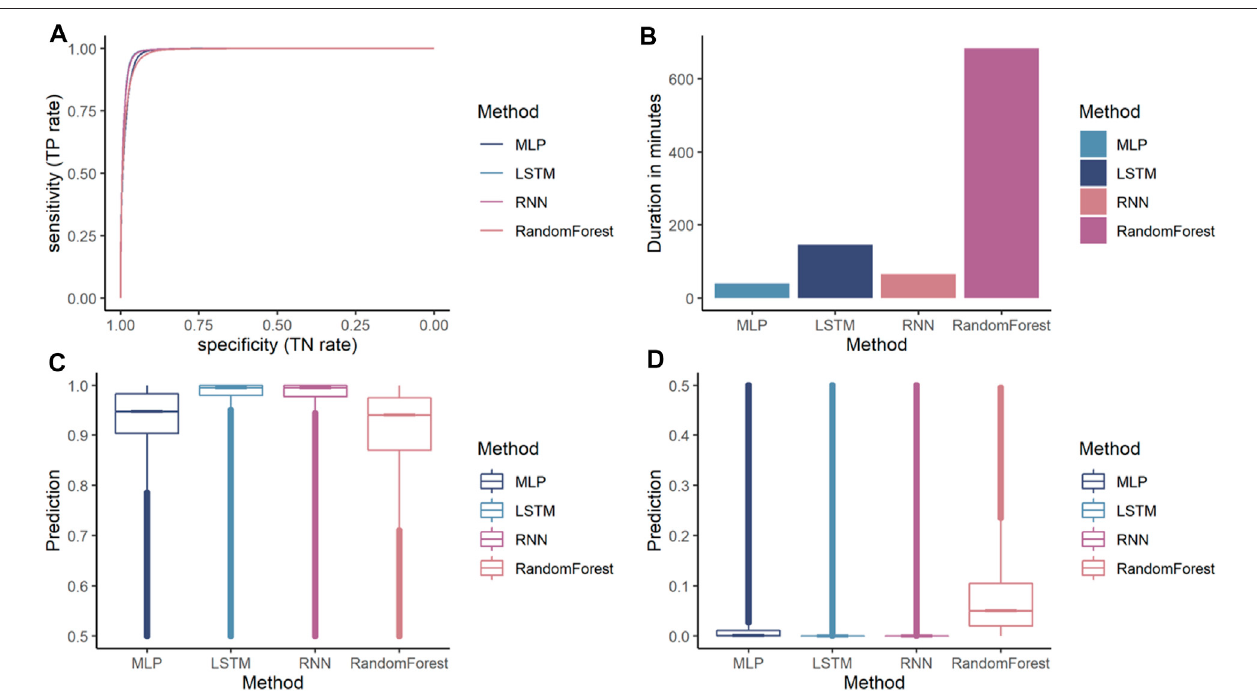
FIGURE 5 | Comparison of different machine learning models on dengue CDR3 sequences. (A) Receiver Operating Characteristic (ROC) curves for MLP, RNN, LSTM, and random forest provides a speci fi city based on the sensitivity. The X-axis shows the speci fi city in function of the sensitivity (100-Sensitivity, false-positive rate) whiletheY-axisshowsthesensitivity(truepositiverate). (B) Trainingtimesofonek-fold(Y-axis)forthegivenMLmodels(X-axis)indicatingthatrandomforestisbyfarthe mostcomputationallyintensemodels.MLPandRNNareroughlythesamewhileLSTMneedsapproximatelytwiceaslongcomparedtotheotherANNmodels. (C) Median, con fi dence intervals, fi rst and third quartile, and min and max values for the positive class (dengue). This indicates that the con fi dence for most dengue predictions is highest for the LSTM model, followed by the other ANN and random forest predicting with lowest con fi dence. (D) Median, con fi dence intervals, fi rst and third quartile, min and max values for the negative class (background). This indicates that LSTM and RNN are the most con fi dent in predicting the background class followed by the MLP.